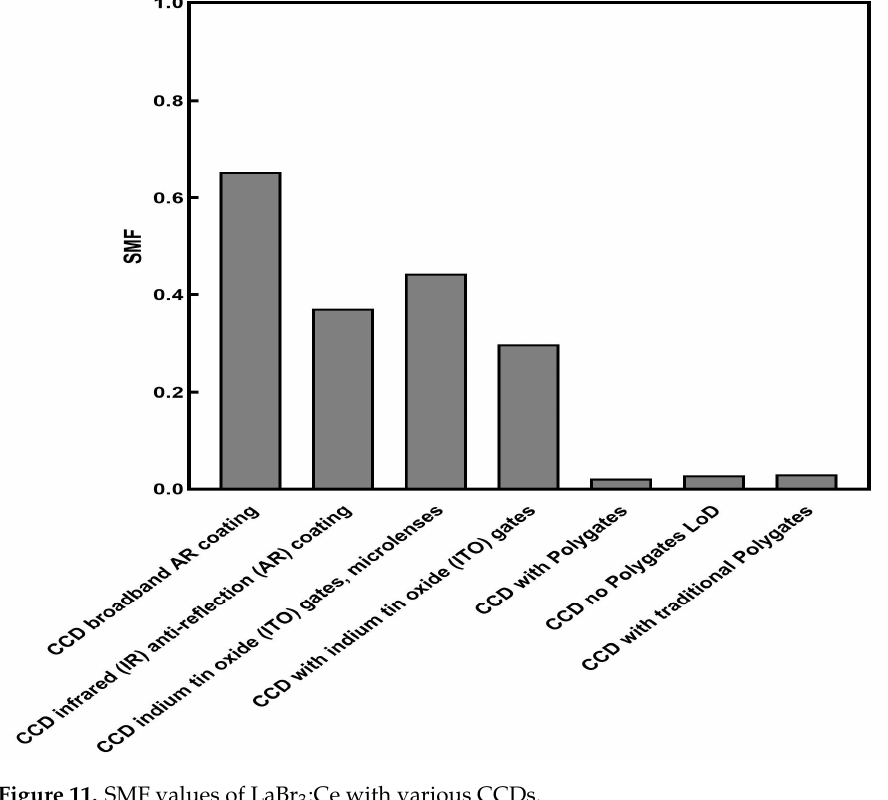
Figure 11. SMF values of LaBr 3 :Ce with various CCDs.